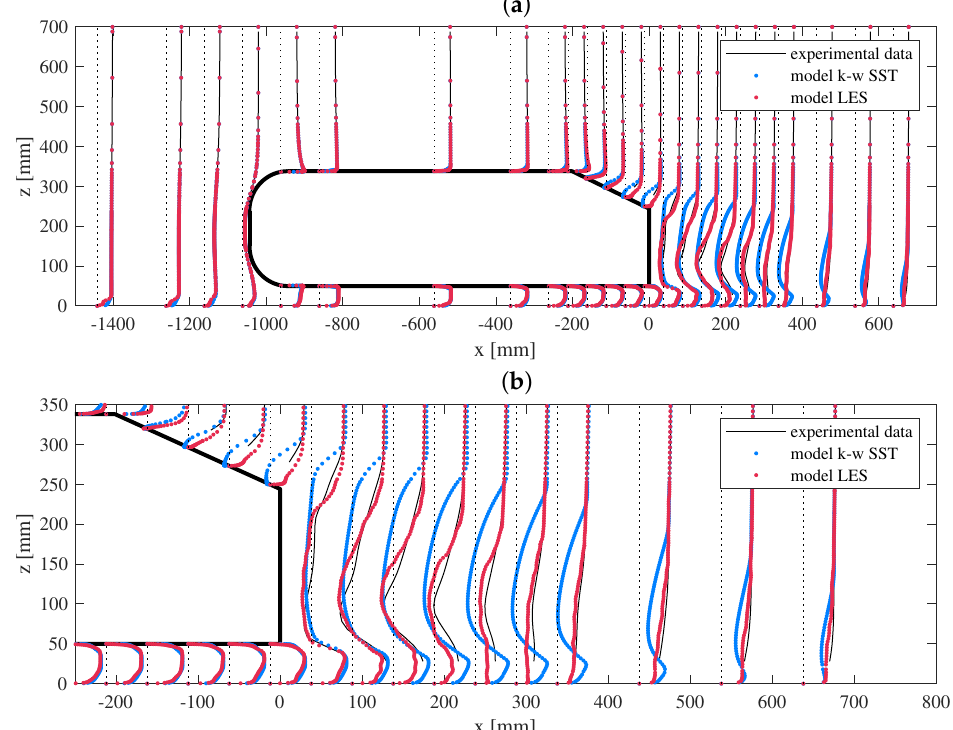
Figure 9. Streamwise velocity profiles in the symmetry plane y = 0. Black lines for experimental data, blue dots for model k − ω SST, red dots for model LES. ( a ) General view; ( b ) zoom at the back of the Ahmed